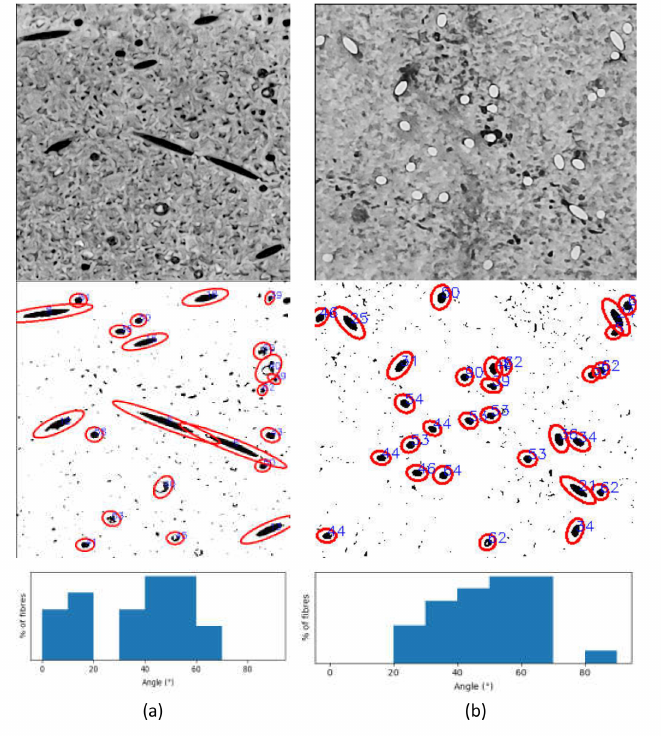
Figure 3. Distribution of fibres at ( a ) 1%, and ( b ) 3%. Note that the numbers denote the angle to the